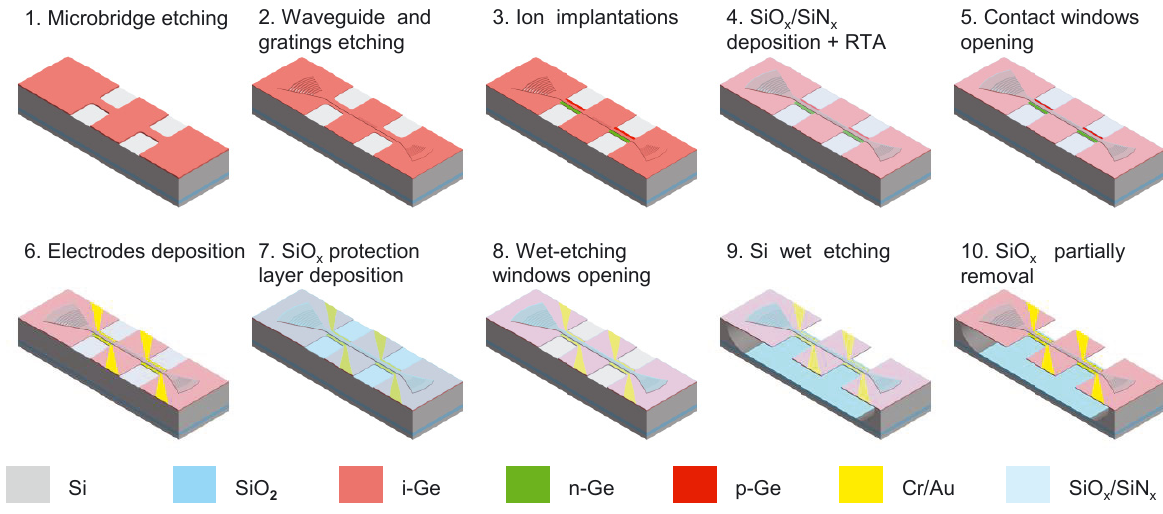
Figure 4: A simplified fabrication flow of the double strained-microbridge cascaded emitting-detecting